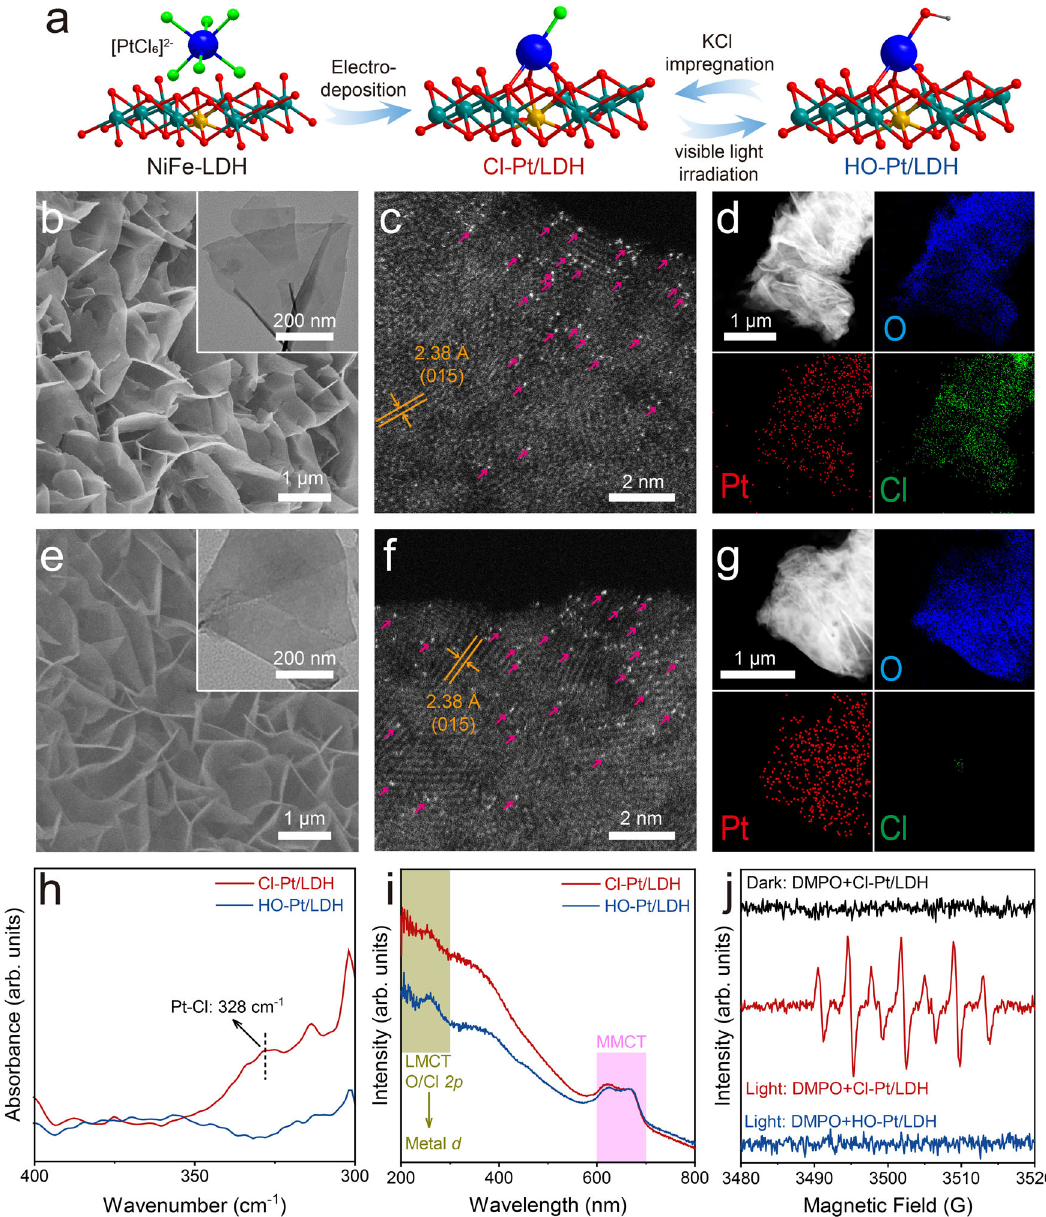
Fig. 1 | Synthetic procedure and structural characterizations of the Cl-Pt/LDH and HO-Pt/LDH. a Schematic illustration of the synthetic and ligand exchange procedure.Atomsareindicatedbyspheres:Pt(blue),Ni(olive),Fe(yellow),O(red), Cl (green), and H (gray). b , e SEM (inset: TEM), ( c , f ) HAADF-STEM, and ( d , g ) corresponding elemental mappings of Cl-Pt/LDH and HO-Pt/LDH, respectively. In